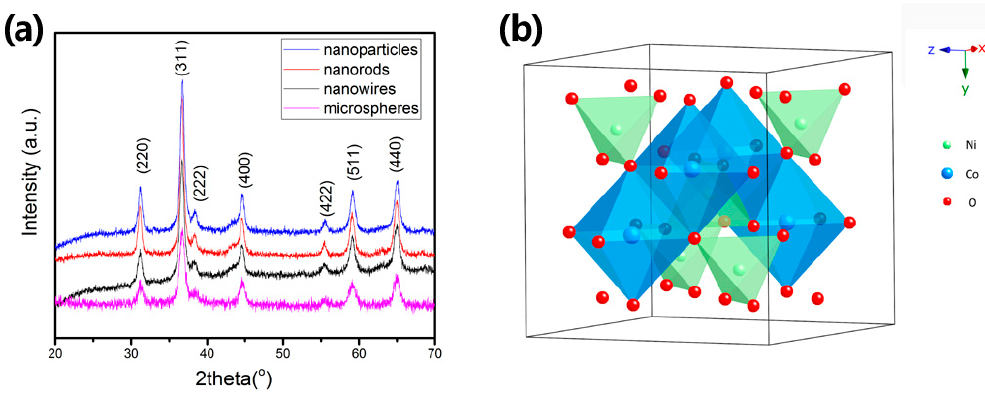
Figure 3. ( a ) X-ray diffraction (XRD) (Cu K α , λ = 0.15406 nm) patterns of as-prepared NiCo 2 O 4 nanostructures; ( b ) structural illustration of spinel NiCo 2 O 4 .